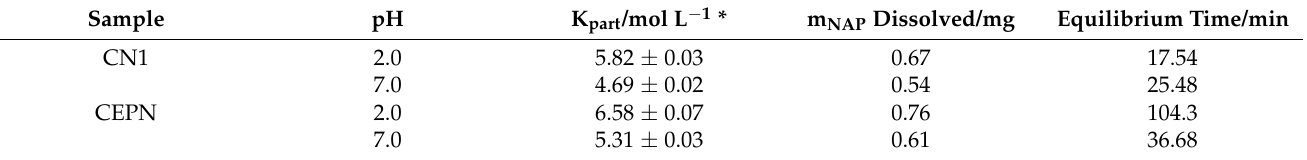
Table 6. Values of the concentration of NAP in the equilibrium (partition constant), equilibrium time and released mass in solution in the experiments of pH 2.00 and